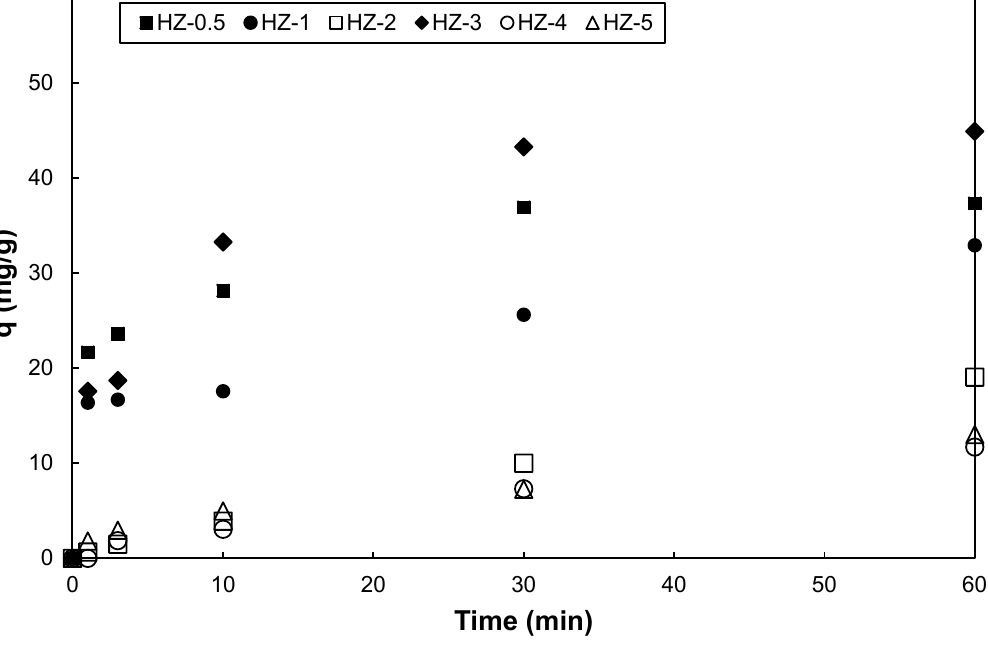
Figure 6. Cesium adsorption capacities of the synthesized composite samples measured from the ICP-MS tests.